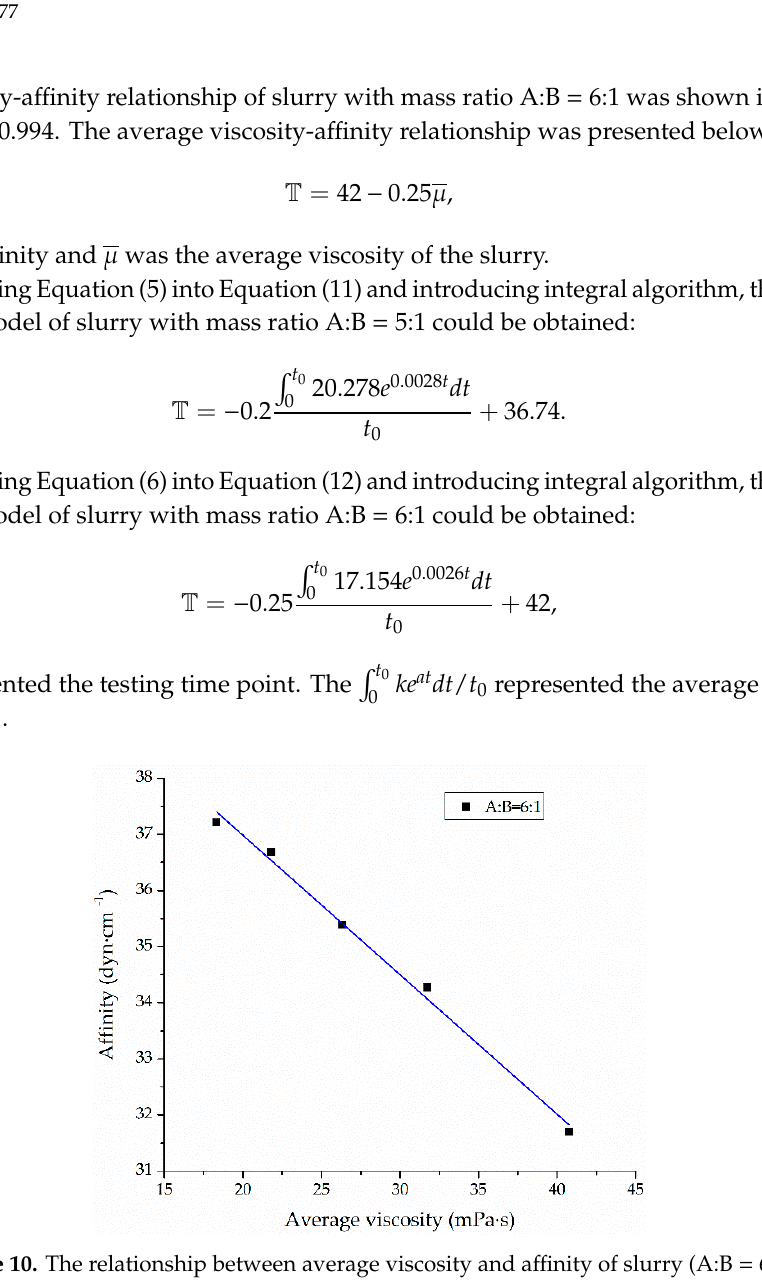
Figure 10. The relationship between average viscosity and affinity of slurry (A:B = 6:1).